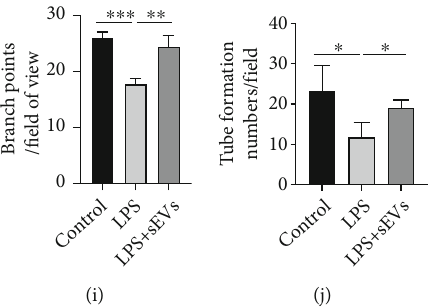
Figure 2: The sEVs enhanced proangiogenic potential of CFs. Primary CFs were treated with LPS (100ng/mL) and LPS+sEVs (200 μ g/mL) for 24 h, and supernatants were collected. HUVECs were treated with the supernatants derived from pretreated CFs. (a) Proliferation of HUVECs was detected by the CCK-8 assay. (b) The mRNA expression of cyclin D1 was measured by qRT-PCR. (c) Cyclin D1 protein expression was detected by western blotting. (d, f) Migration of HUVECs in di ff erent treatment groups was tested by the wound healing assay (d) and Transwell migration assay (f). Scale bar: 500 μ m (d) and 100 μ m (f). (e) Quantitative analysis of 12h migration rate in (d). (g) Quantitative analysis of migrated cells in (f). (h – j) Tube formation ability of HUVECs was measured by the tube formation assay (h). Quantitative analysis of the total branching points (i) and tube formation numbers (j). Scale bar: 500 μ m. ∗ P < 0 : 05 , ∗∗ P < 0 : 01 , ∗∗∗ P < 0 : 001 , and ∗∗∗∗ P < 0 : 0001